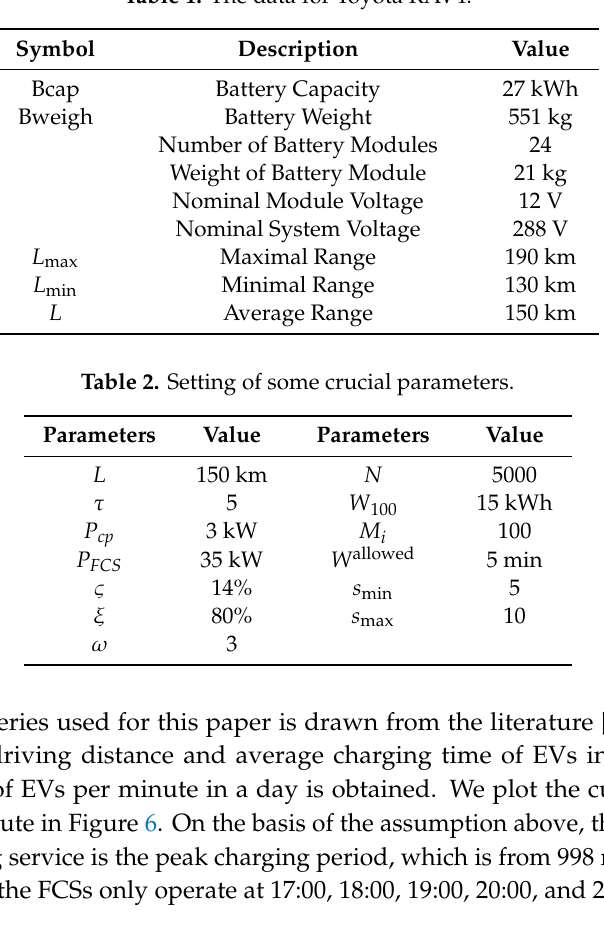
Table 1. The data for Toyota RAV4.